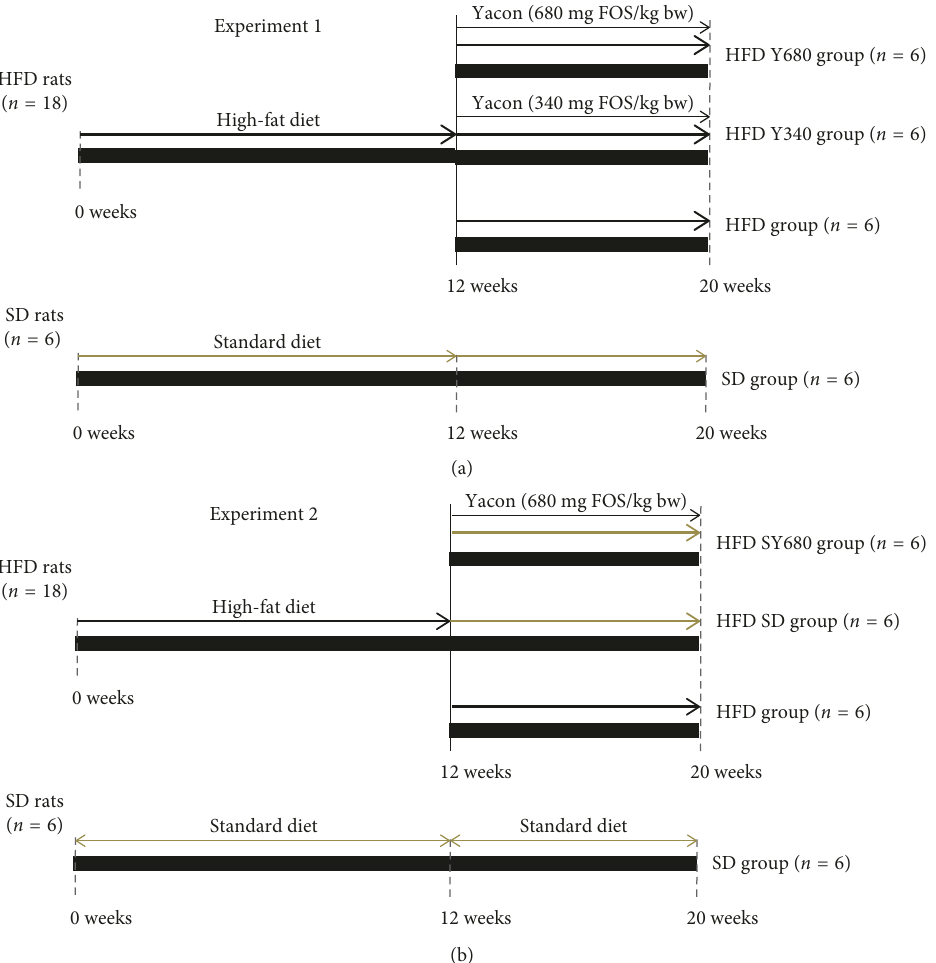
Figure 1: Experimental design. (a) Experiment 1: effects of the yacon flour on HFD-induced metabolic disease. (b) Experiment 2: effects of yacon supplementation and the reversion to a SD diet on HFD-induced metabolic disease. SD: standard diet-fed rats; HFD: high-fat-diet-fed rats; HFD SD: high-fat-diet-fed rats reversed to a SD diet; HFD SY680: high-fat-diet-fed rats reversed to a SD diet and supplemented with yacon flour (680 mg FOS/kg